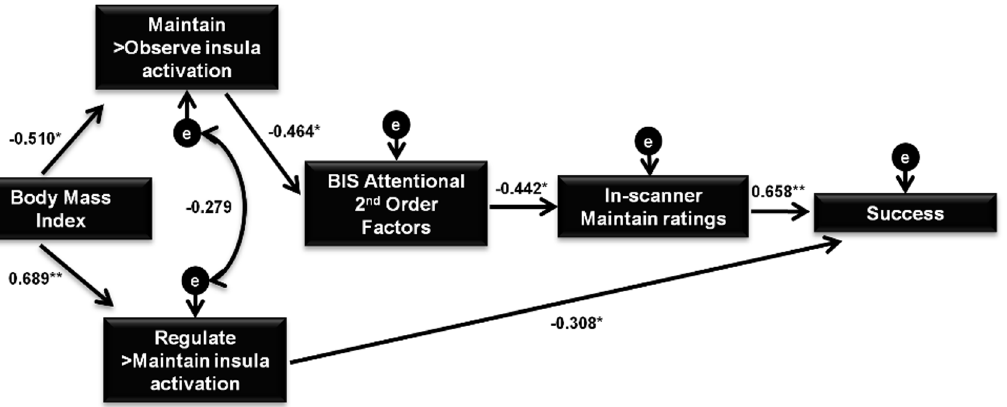
Fig 5. Final Path Analysis Model. Model 3 was the best representation of the observed relationship between variables and examined the complex associations between Body Mass Index (BMI), neuroimaging results and behavioral data. BIS-11 = Barratt Impulsiveness Scale; Standardized regression weights for direct effects are shown * p < 0.05 ** p <